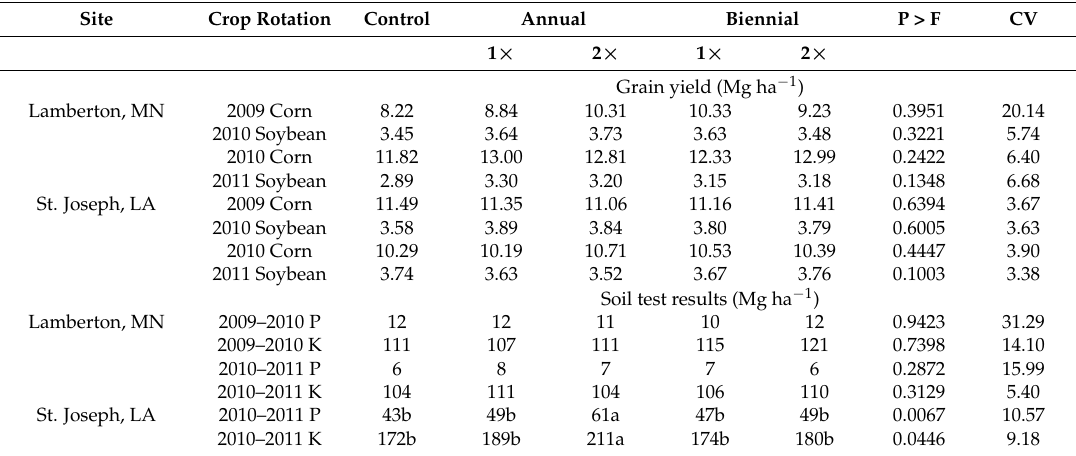
Table 7. Corn and soybean grain yield and soil test results affected by fertilizer treatments at sites with above optimal P and optimal